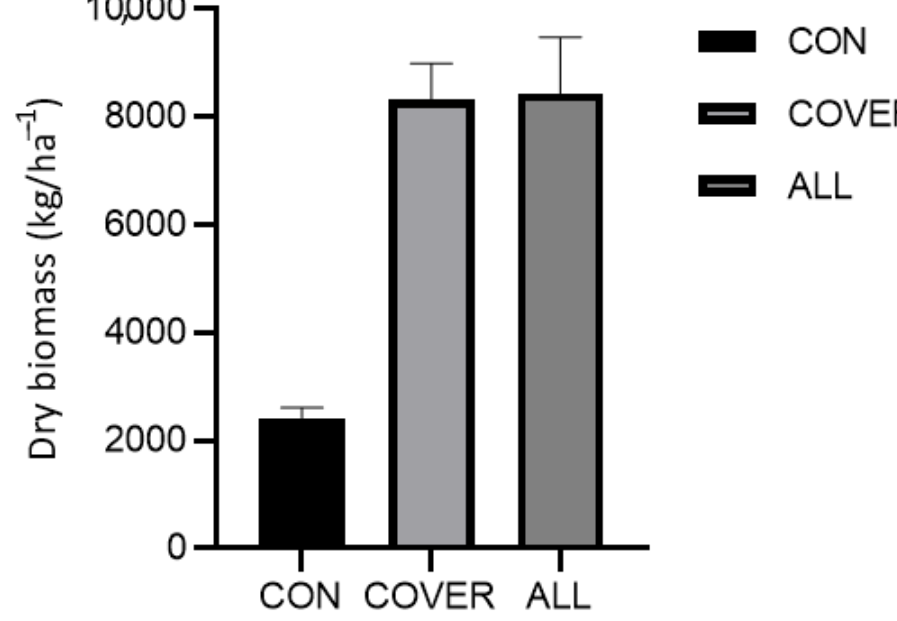
Figure 3. Dry biomass of seeded cover crops in COVER and ALL treatments and spontaneous plants in CON treatment using one-way ANOVA separately for fresh and dry biomass. Mean values ± SE per each treatment is presented. Different letters indicate significance at p < 0.05 (LSD test).